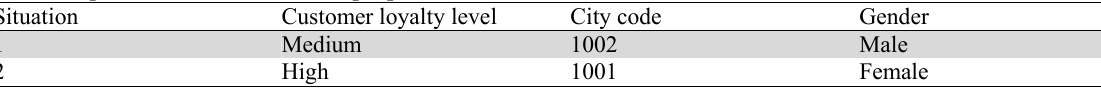
Two example situations used in the proposed model